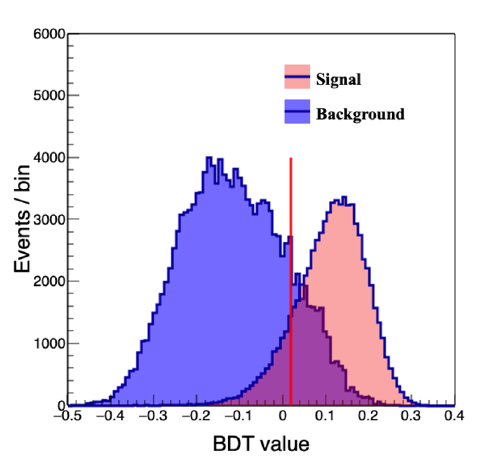
Figure 6 . BDT output distributions for signal and background events. The samples used here are those passed all the cuts introduced